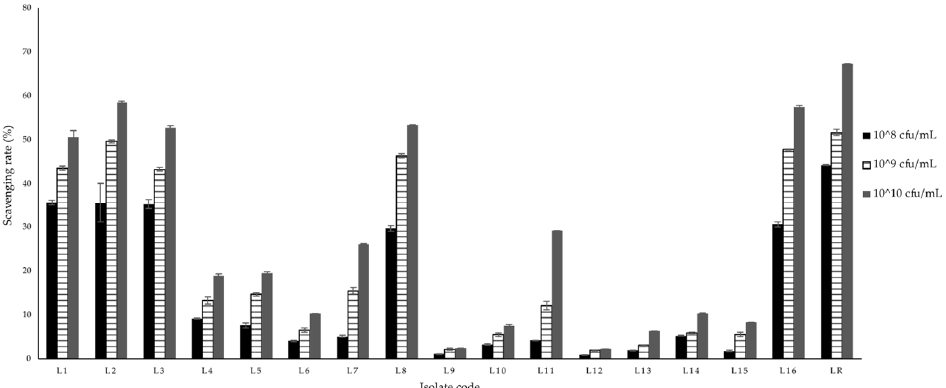
Figure 5. Scavenging of hydroxyl radical by intracellular cell-free extract of Leuconostoc mesenteroides subsp. mesenteroides isolates. (Isolate code: L1–L16: Leuconostoc mesenteroides subsp. mesenteroides, LR: Lactobacillus reuteri Protectis DSM17938). Each value is expressed as mean ± SD (n = 3). Data points denoted with a # bear no statistically significant difference to LR.